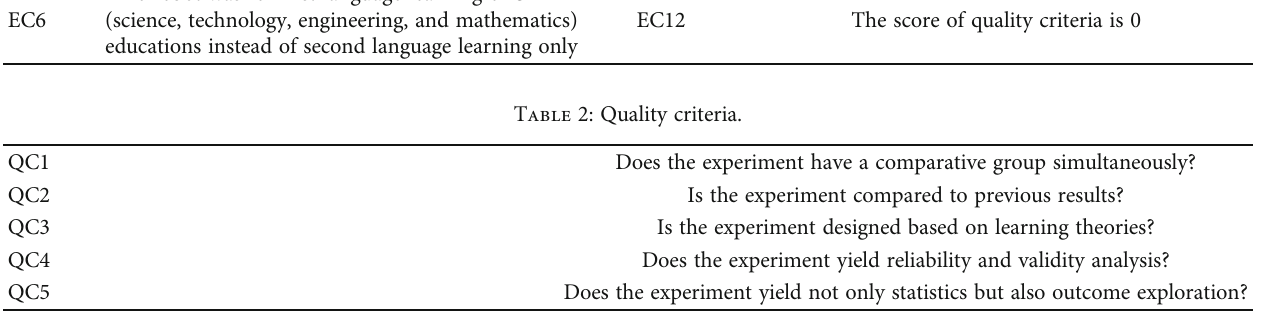
Table 3. Seven out of 26 items were extracted to collect help- ful information for this article (Table 4).